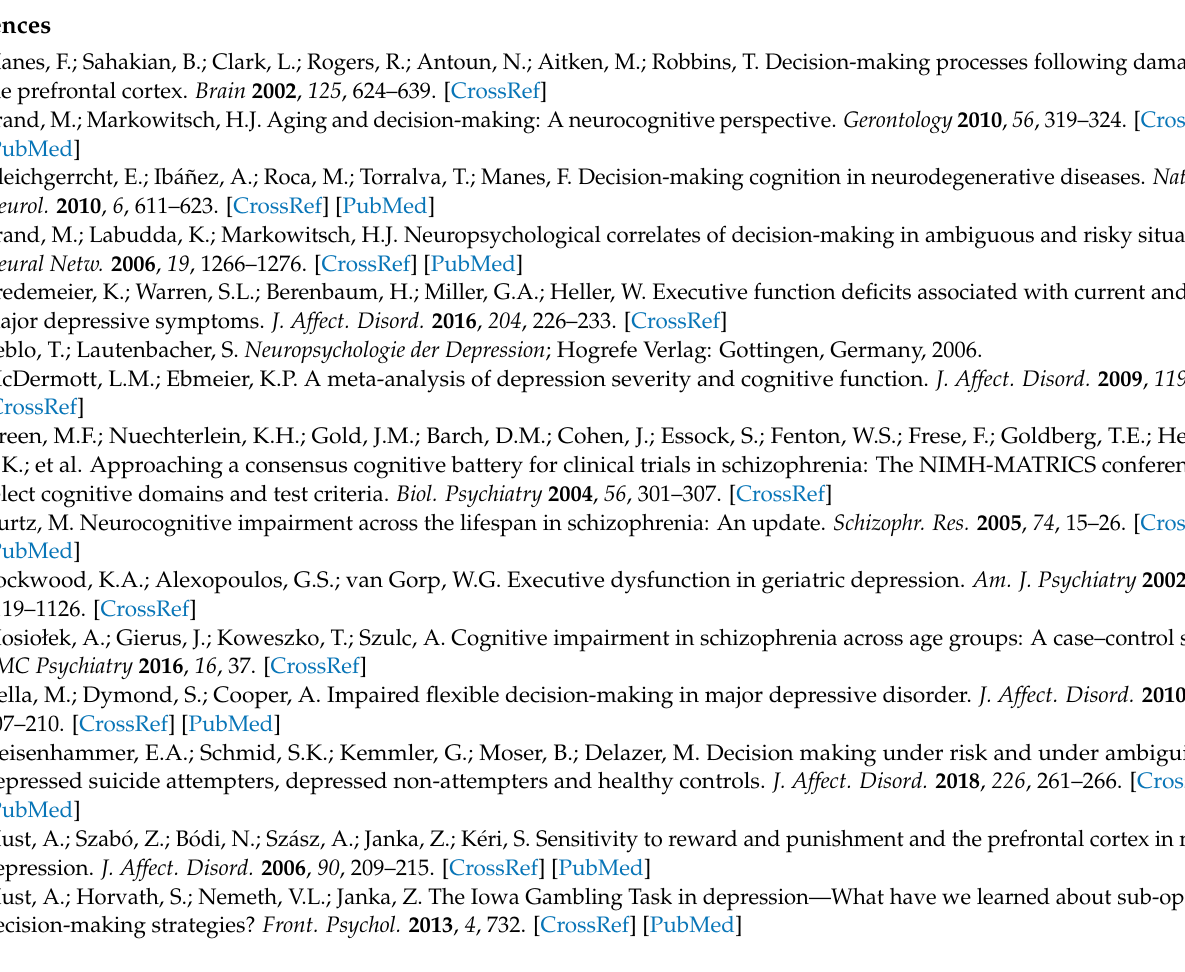
Table S2: Fisher’s-z-transformations for the comparison of the Pearson’s correlation coefficients between patients with major depression (n = 28) and healthy controls (n =